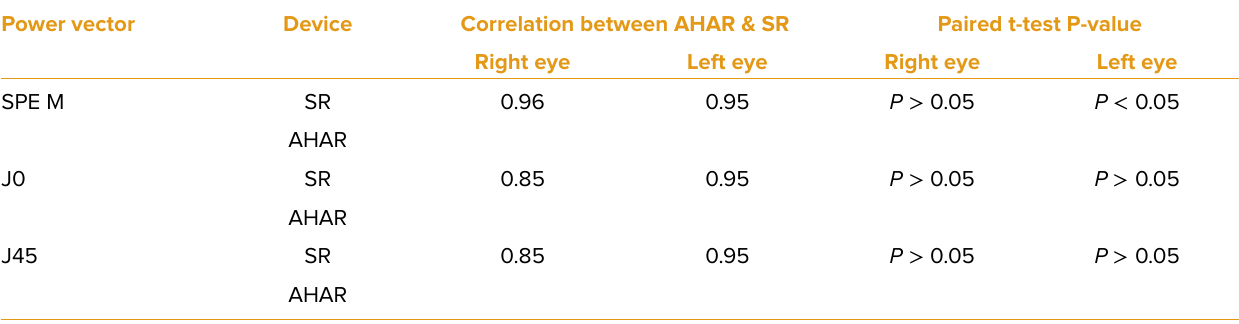
Table 4. Statistical analysis of the power vector errors in SR and 3nethra AHAR. Power vector Device Correlation between AHAR & SR Paired t-test P-value Right